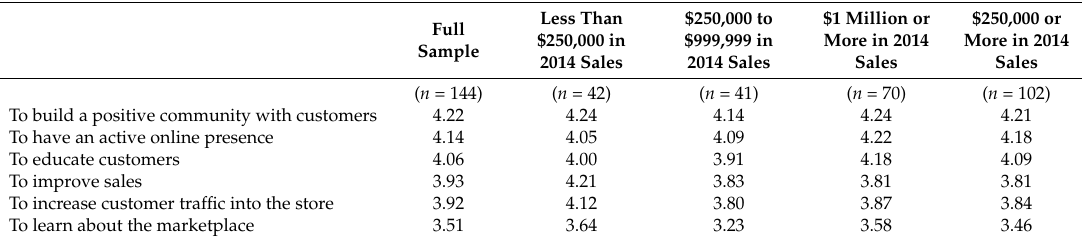
Table 7. Perceived importance of social media by ornamental horticulture industry respondents in the study questionnaire a